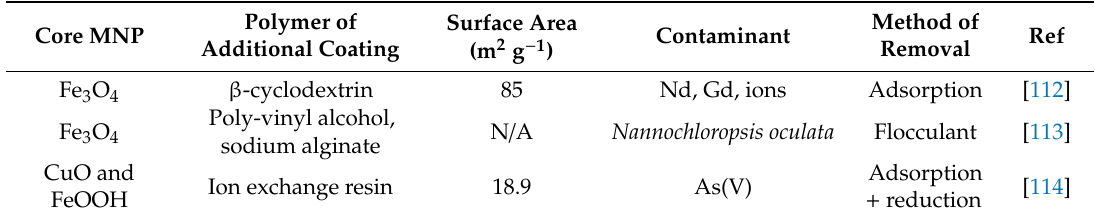
Table 6. Magnetic nanocomposites made with polymers with reported targeted contaminant and method of